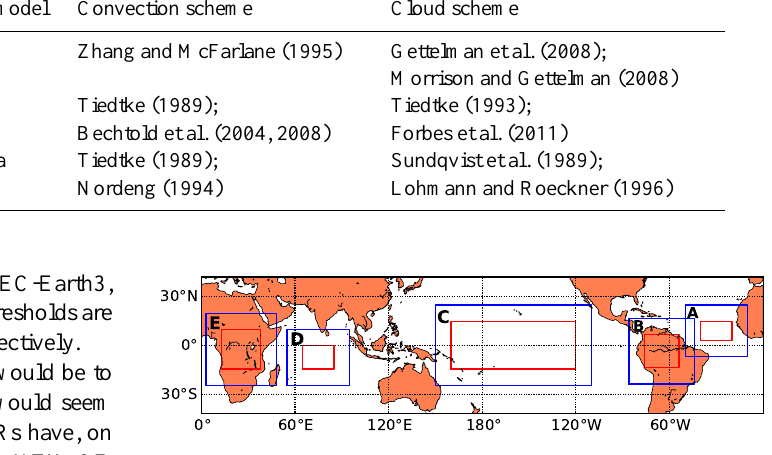
Figure 1. Selected regions of deep convection across the tropics: central Atlantic (A), the Amazon Basin (B), Pacific Ocean (C), In- dian Ocean (D), and central Africa (E). Ocean-based regions are the combination of D, C, and A; land-based regions are E and B. Red areas represent DC system centre regions, while blue boxes are data sampling